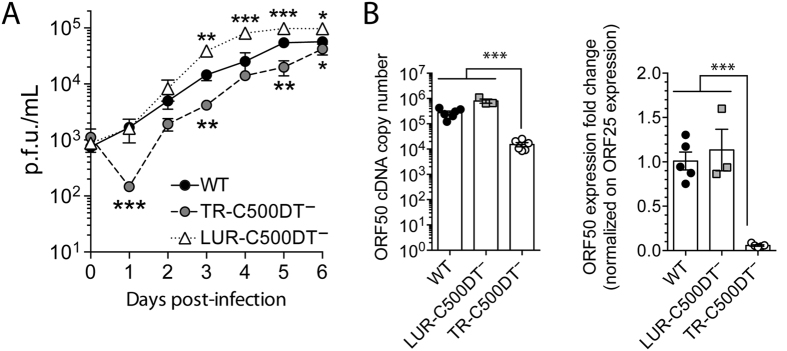
Effects of the duplicated region on viral fitness in vitro.(A) Multistep growth curves of WT, LUR-C500DT− and TR-C500DT− viruses in BT cells. Data are means ± S.D. from triplicate independent measurements and representative of two independent experiments with similar results. Statistical analysis was done by two-way ANOVA with the Bonferroni test for multiple comparisons; *p ≤ 0.01, **p ≤ 0.05, ***p ≤ 0.001. (B) ORF50 mRNA expression in MDBK cells 3 days post-infection (moi = 0.01) with WT, LUR-C500DT− or TR-C500DT− viruses. Expression levels are given as absolute copy numbers from an RT reaction of 1 μg of cytoplasmic RNA and as normalized ORF50/ORF25 ratios. Data are means ± S.D. from measurements carried out in triplicate. Statistical analysis was done by Student t test, ***p ≤ 0.001.